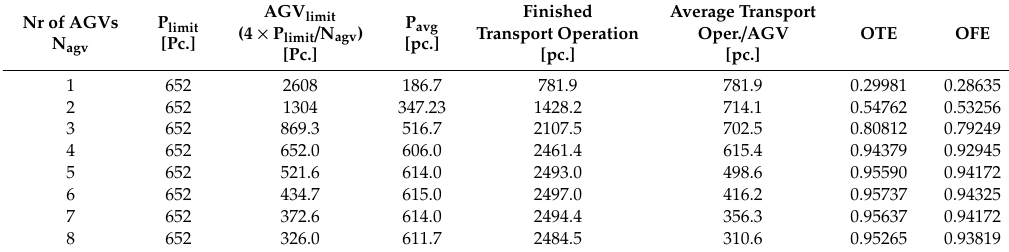
Table 5. OTE—Overall Transport E ff ectiveness and OFE—Overall Factory E ff ectiveness (24 h of simulation, 30 simulation runs in each experiment, without failures and battery charging). AGV limit Finished Average Transport Nr of AGVs P limit P avg (4 × P limit / N agv ) Transport Operation Oper. / AGV N agv [Pc.] [pc.] [Pc.] [pc.]